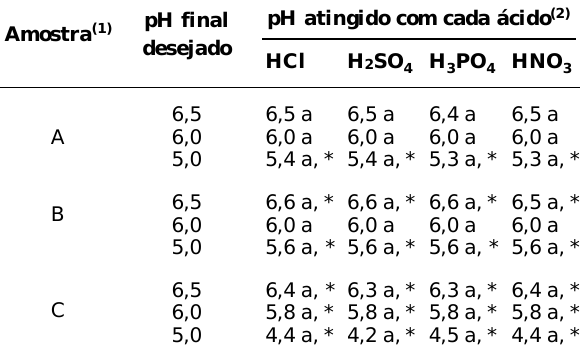
PO ; (b) HCl; (c) H 3 4